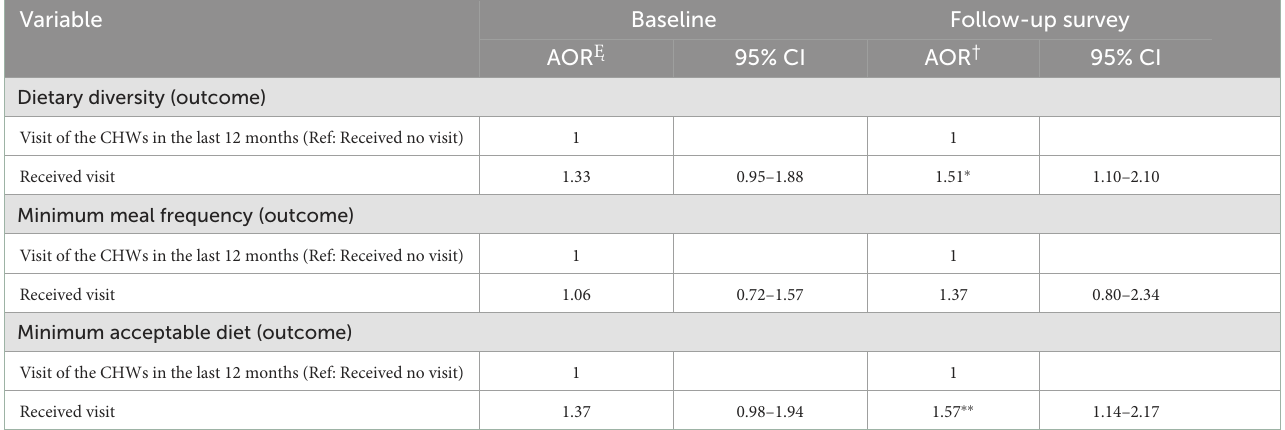
TABLE 3 Association of exposure variable with complementary feeding practices.